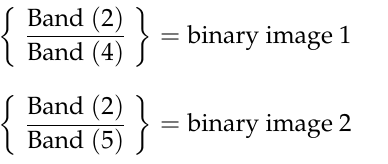
{ binary image 1 }·{ binary image 2 } = binary image